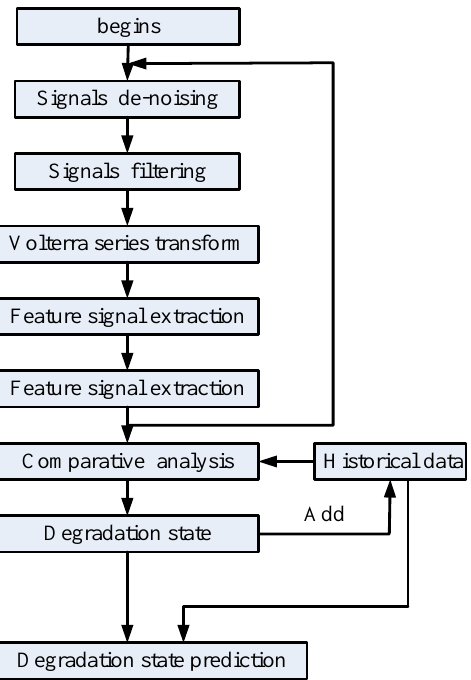
Figure 5. Program flow chart of degradation state judgment and prediction for MOSFET.